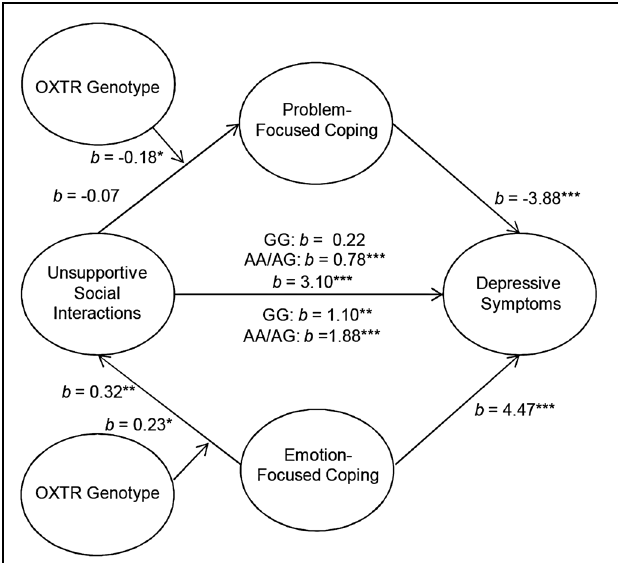
FIGURE 1 | Schematic of the moderated multiple mediation analyses examining parental unsupport. The relation between unsupportive social interactions from parents and depressive symptoms through problem-focused coping was moderated by oxytocin receptor gene (OXTR) rs53576 genotype, such that it was only significant among A carriers. As well, the relation between unsupportive responses from parents and depressive symptoms through emotion-focused coping as moderated by OXTR genotype. This mediated model was significant irrespective of genotype, but was stronger among A carriers. ∗ p ≤ 0.05, ∗∗ p < 0.01, ∗∗∗ p < 0.001.